Question: Write the caption for this figure.
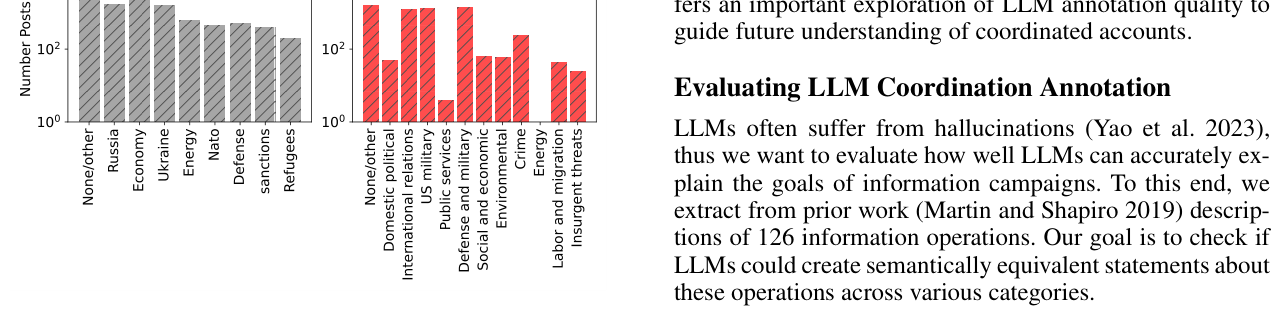
Answer: The frequency of concern posts in human anno- tated validation data. (a) 2022 French election and (b) 2023 Balikatan U.S.-Philippines military exercises.